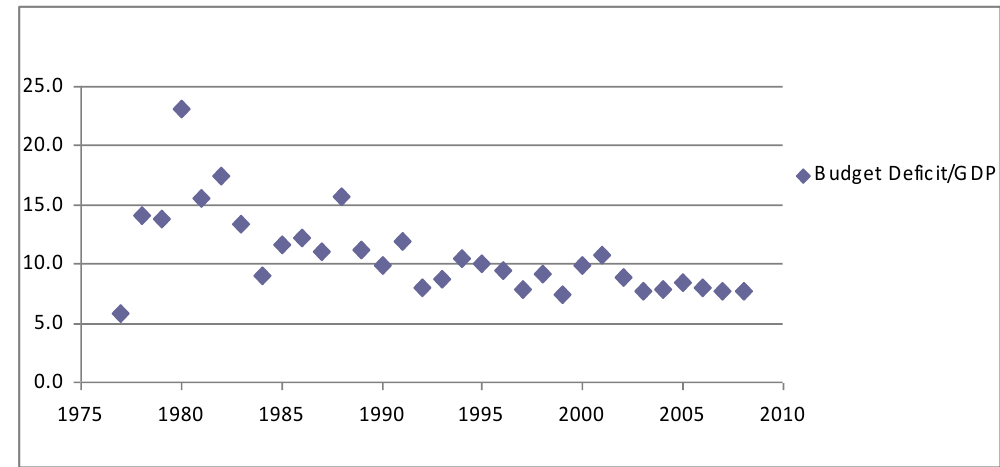
Figure 2: Budget Deficit (Percentage of GDP) Source: Central Bank of Sri Lanka, Annual Reports